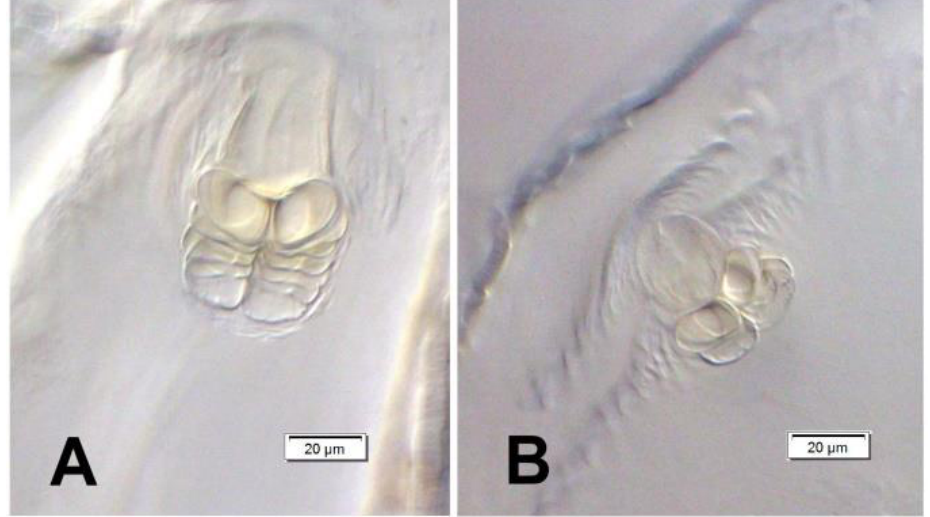
Figure 4. Euryommatus mariae mature larva, spiracles. ( A ) Spiracle of prothorax; ( B ) spiracle of ab- dominal segment I.